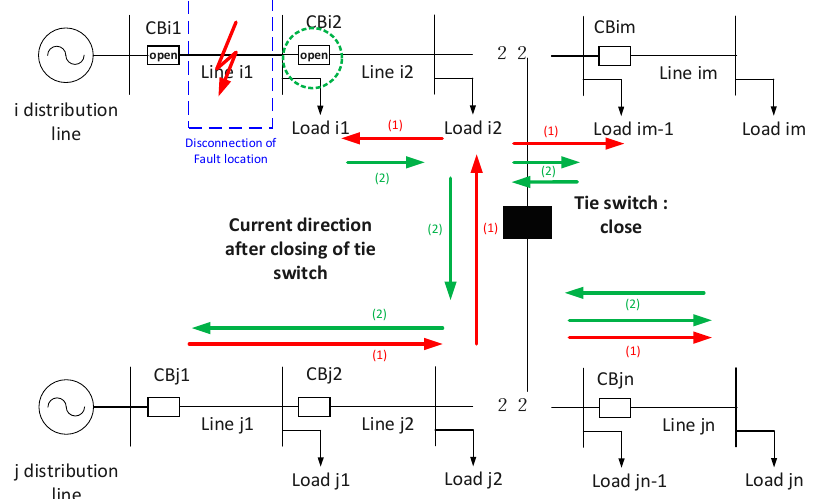
Figure 4. Current flow after the closing of the tie switch when the fault section is successfully disconnected.